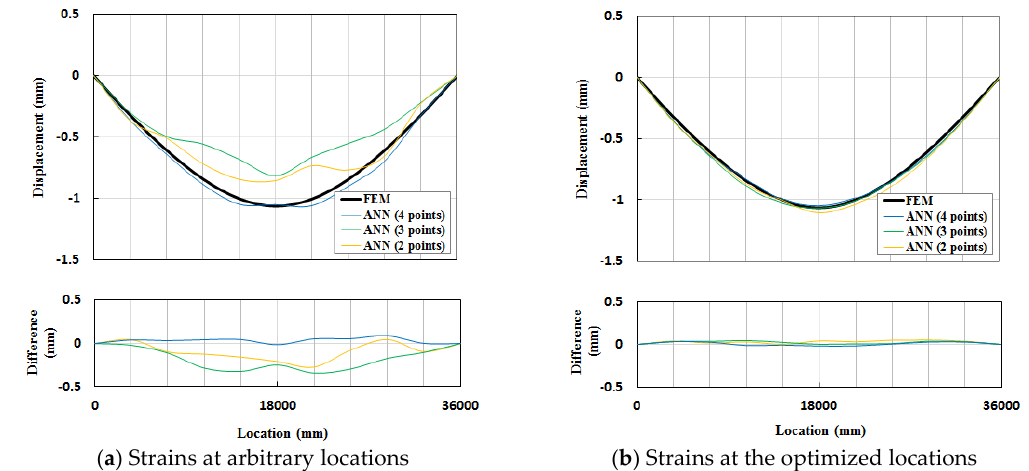
Figure 16. Overall displacements shape at t = 1.75 s (max. displacement) for the 60 km/h test dataset.